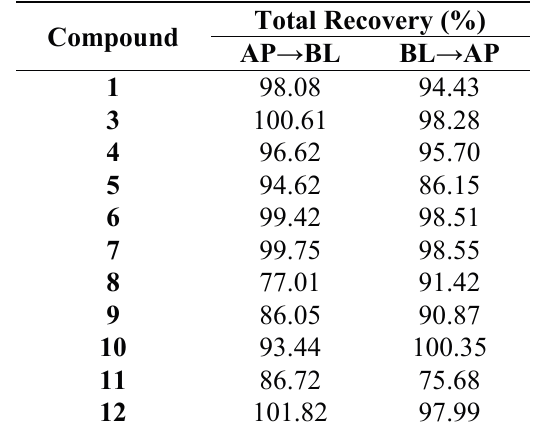
Table 2. Total recoveries of the eleven compounds of TMF in the Caco-2 model.